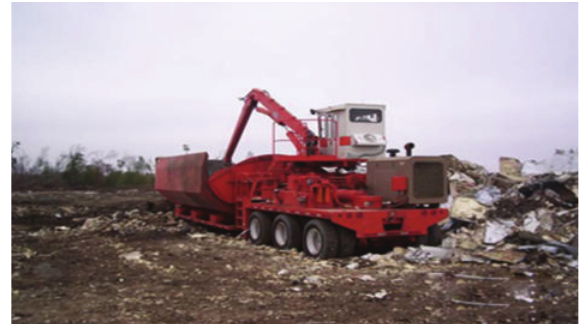
Figure 11: Electronic waste wrapped for shipping to electronic scrap processors. Picture provided courtesy of USACE.